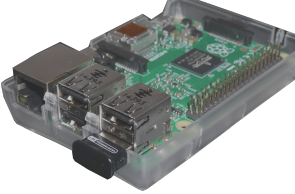
Figure 2. Raspberry Pi-based beacon.